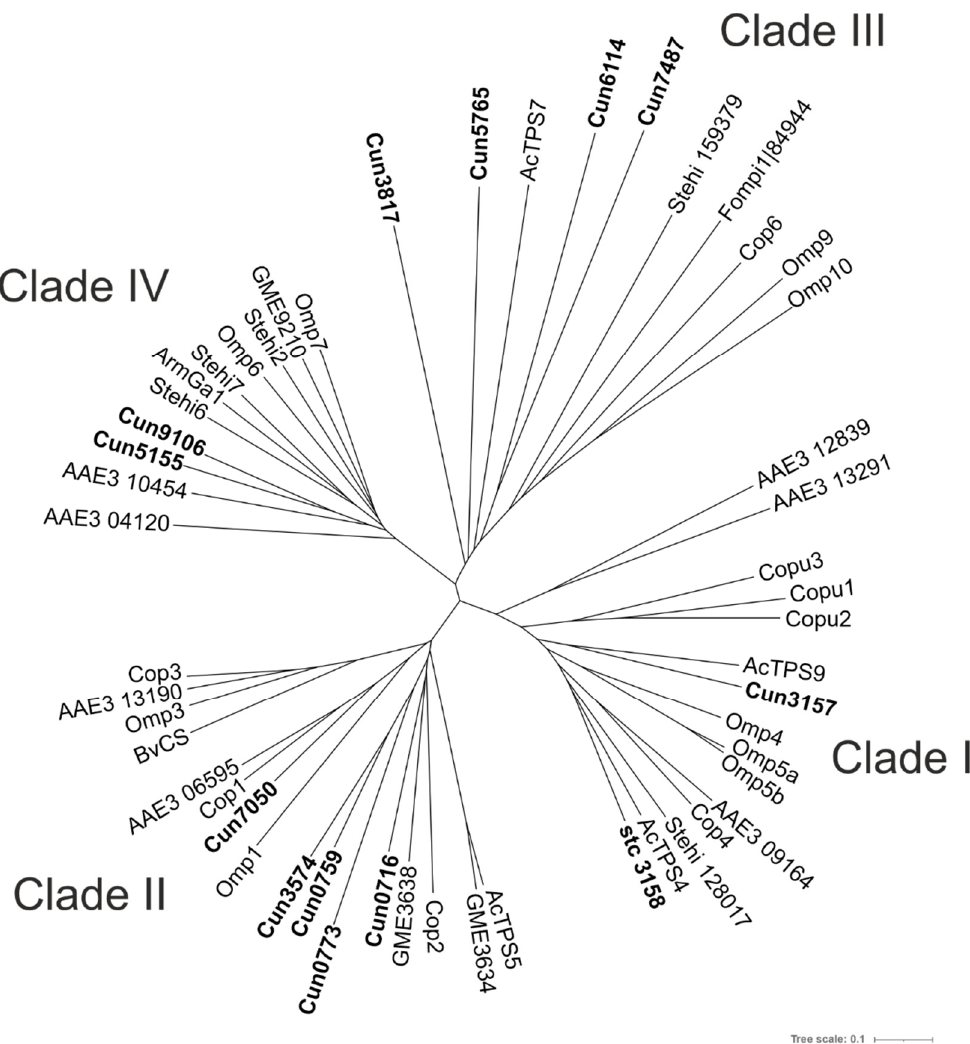
Figure 2. Phylogenetic determination of sesquiterpene synthases from basidiomycota. Unrooted neighbor-joining phylogram of 37 experimental characterized STS. Included are STS protein sequences from Antrodia cinnamomea (AcTPS) [33], Armillaria gallica (ArmGa) [34], Boreostereum vibrans (BvCS) [35], Coprinopsis cinereus (Cop) [30], Coniophora puteana (Copu) [26], Formitopsis pinicola (Fompi) [25], Lignosus rhinoceros (GME) [36], Stereum hirsutum (Stehi) [27], Omphalotus olearius (Omp) [25], and Cerrena unicolor (Cun). Different cyclisation mechanisms were found for the clades. Clades 1 and 2 follow an initial 1,10-cyclization, clade 3 follows a 1,6-cyclization, and clade 4 follows a 1,11-cyclisation. Modified after [26].